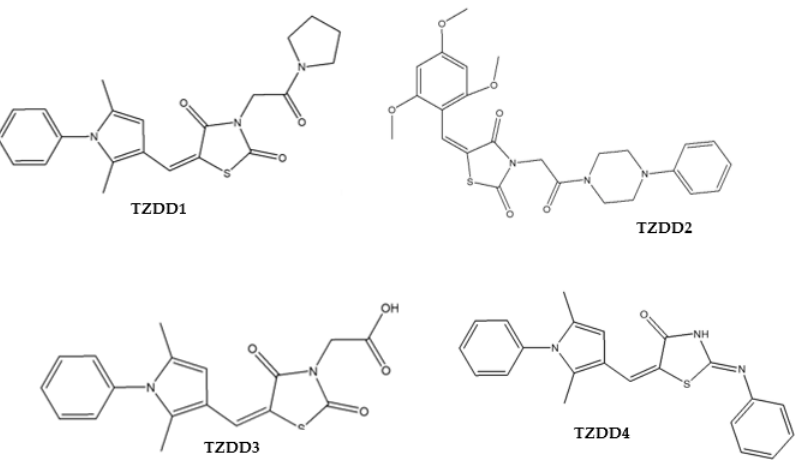
Figure 11. Diagrams showing the synthesised TZD derivatives; (E)-5-(2,4,6-trimethoxybenzylidene)- 3-(2-oxo-2-(4-phenylpiperazin-1-yl)ethyl)thiazolidine-2,4-dione (TZDD1); (E)-5-((2,5-dimethyl-1- phenyl-1H-pyrrol-3-yl)methylene)-3-(2-oxo-2-(yrrolidine-1-yl)ethyl)thiazolidine-2,4-dione (TZDD2); 2-((E)-5-((2,5-dimethyl-1-phenyl-1H-pyrrol-3-yl)methylene)-2,4-dioxothiazolidin-3-yl)acetic acid (TZDD3); (2Z,5E)-5-((2,5-dimethyl-1-phenyl-1H-pyrrol-3-yl)methylene)-2-(phenylimino)thiazolidin- 4-one (TZDD4). (Z)-5-((2,5-Dimethyl-1phenyl-1H-pyrrol-3-yl)methylene)-3-(2-oxo-2-(pyrrolidin-1- yl)ethyl)thiazolidine-2,4-dione, 5a (TZDD2) A yellow solid (57 mg, 79%); m.p. 256–258 ◦ C; R f (n-Hex: EtOAc; 50: 50%) 0.24; IR ν max /cm − 1 : 1729, 1661, 1584 (C=O), 1508 (Ar C=C); δ H (300 MHz, CDCl 3 ): 7.91 (1H, s, H 1 ),